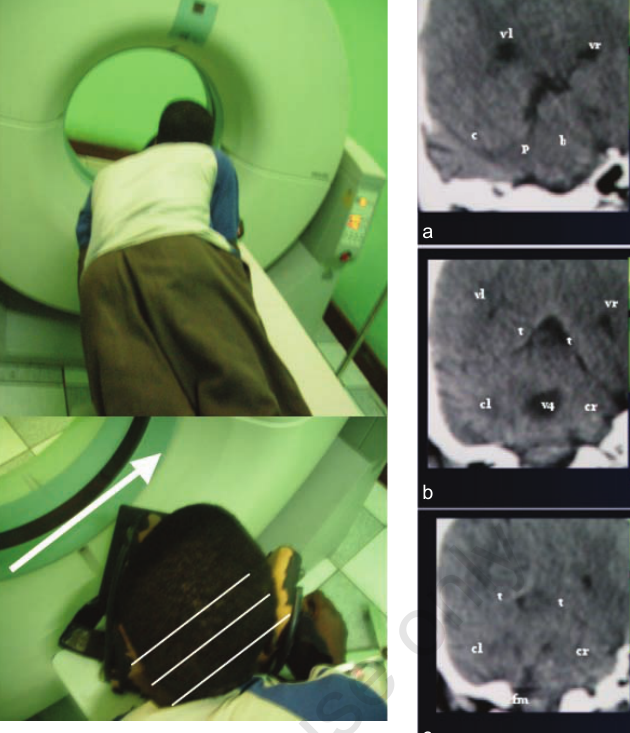
Figure 1. Patient position for obtaining sagit- tal oblique image. The patient is positioned prone with the mid-sagittal plane of the head vertical and the face turned 50° to the right. After studying 100 normal adult brain CTs we established that the petrous ridges are anatomically at 50° to the coronal plane or 40° to the sagittal plane ( S Kampondeni, oral communication, 2008 ). This brings the left petrous ridge parallel to the X-ray beam in the CT gantry. The photographs show patient positioning and direction of scans. Reproducibility in the sagittal oblique scan- ning technique relies on accurate patient positioning: head angulation of 40 degrees to the sagittal plane, keeping the midsgittal plane of the head vertical and maintaining a gantry angulation of 0.